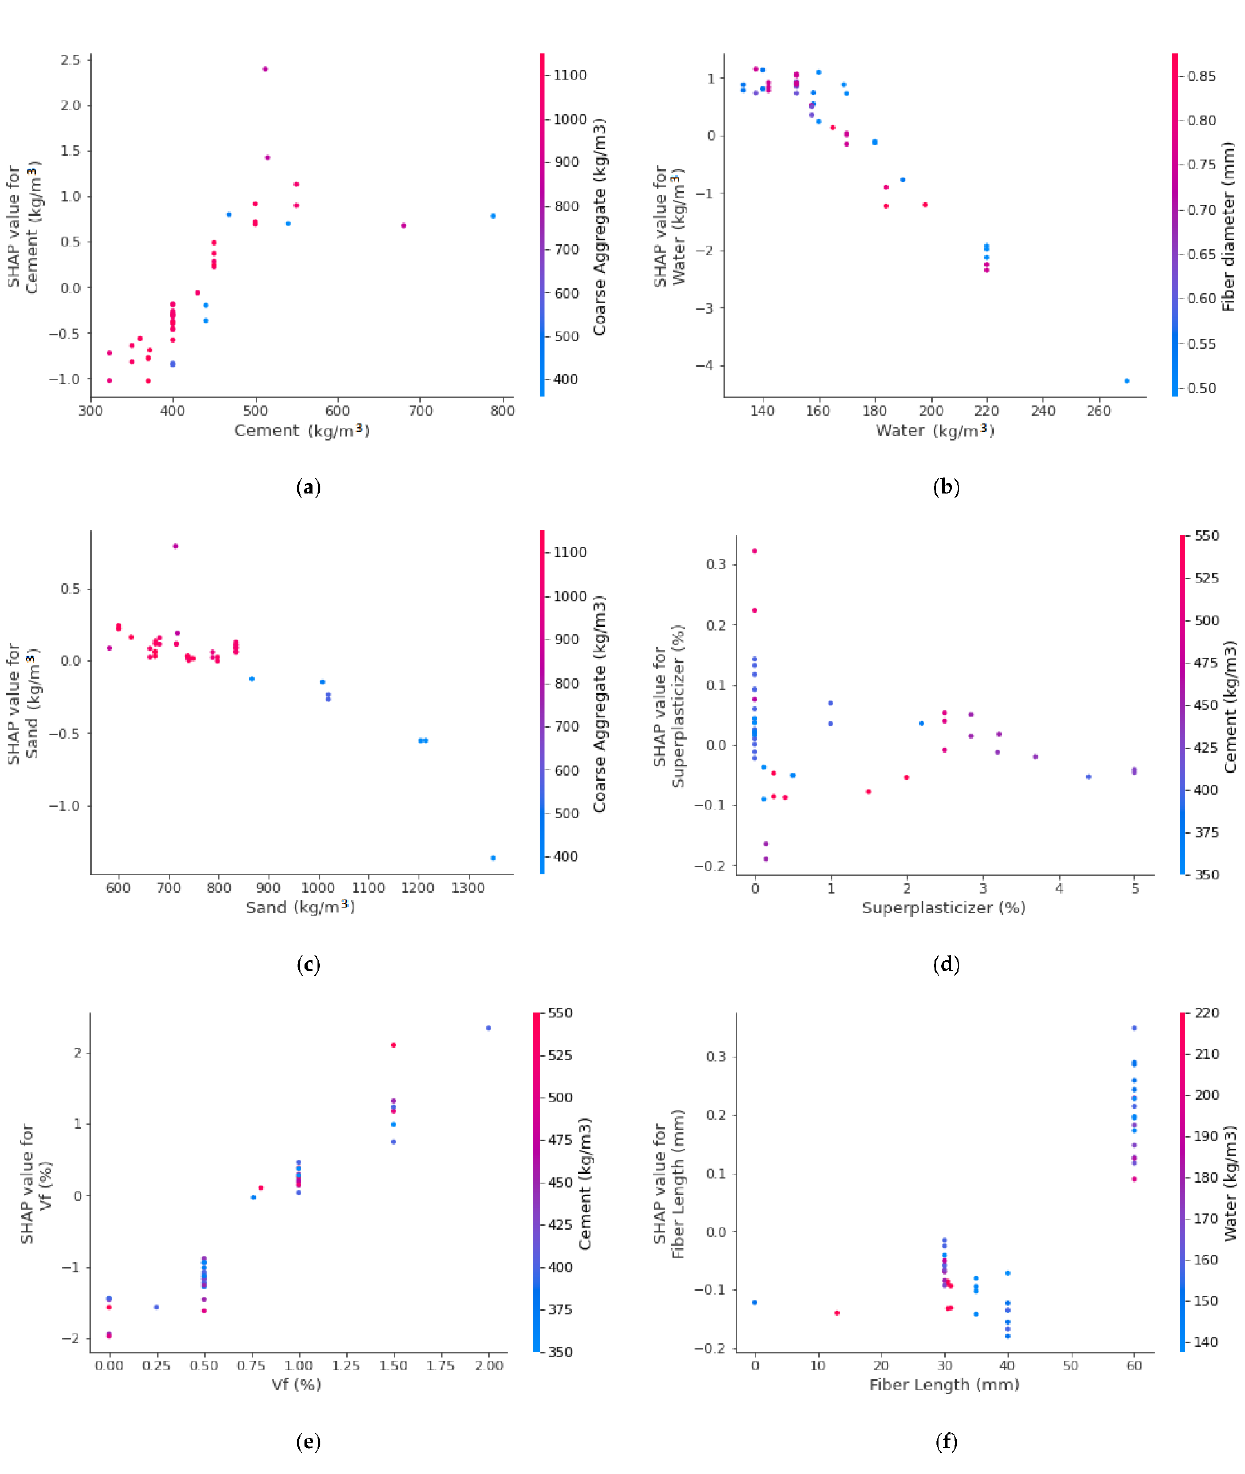
Figure 15. Interaction plot: ( a ) cement; ( b ) water; ( c ) sand; ( d ) superplasticizer; ( e ) Vf; and ( f ) fiber